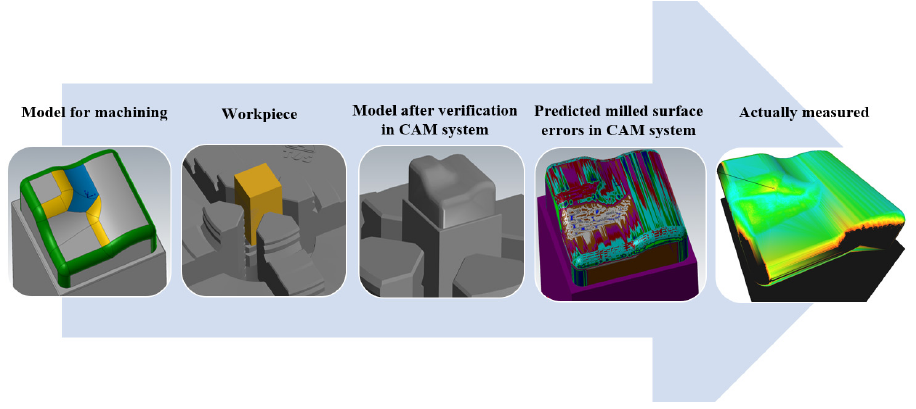
Figure 15. Diagram of the verification procedure of the machining accuracy.